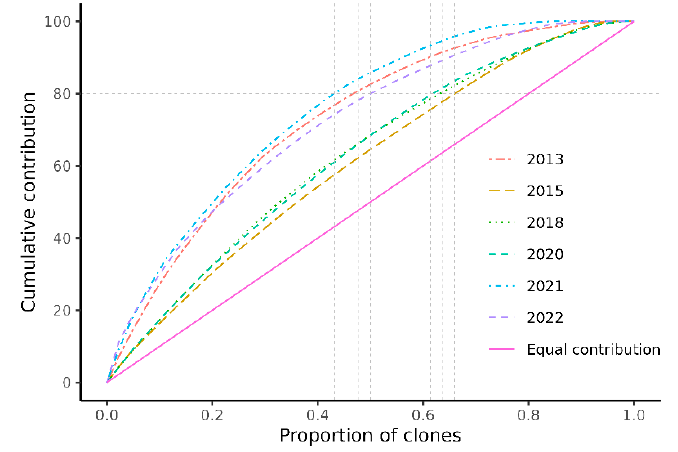
Figure 3. Cone crop parental balance curve over six years, based on the entire orchard clones (n = 44). The straight line represents an ideal orchard with equal contribution among individuals, while the dotted horizontal line is the 20:80 rule.